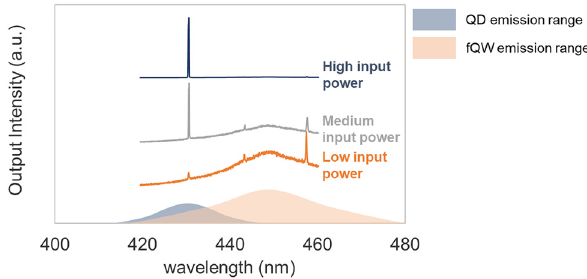
Figure 2: Illustrative example of the dominant mode shifting in a microdisk from the fQW regime to the QD regime with increasing input power. “ Low input power ” is far below the lasing threshold. “ Medium input power ” is slightly higher but still below the lasing threshold. “ High power ” is above the lasing threshold. Modes are indicated by the sharp peaks decorating the background emission. fQW, fragmented quantum well; QD, quantum